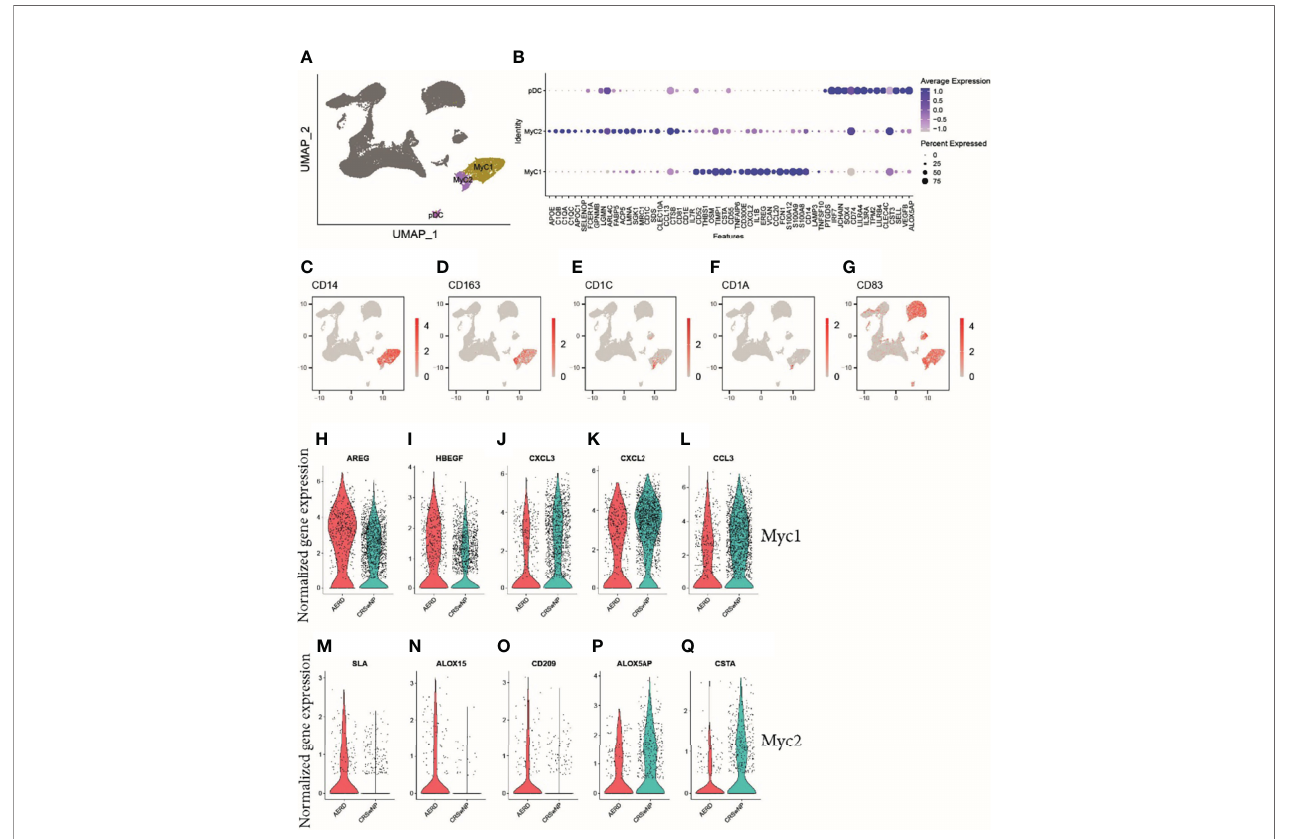
FIGURE 5 | Gene expression of myeloid cells and plasmacytoid dendritic cells in patients with AERD or CRSwNP. (A) Color-coded UMAP plot of scRNA-seq MyC and pDC subclusters. (B) Dot plots showing selected marker genes within MyC1, MyC2, and pDC displaying z-score of average expression (blue color intensity) and frequency of gene expression (circle size). (C – G) Feature plots identifying combined natural log-transformed normalized expression. Red color displays intensity levels of natural log-transformed gene expression. (H – Q) Violin plots showing natural log-transformed normalized gene expression for selected DEG in AERD (red) versus CRSwNP (blue) patients in (H – L) MyC1 and (M – Q) MyC2. AERD, aspirin-exacerbated respiratory disease; CRSwNP, chronic rhinosinusitis with nasal polyps; DEG, differentially expressed genes; MyC, myeloid cell; pDC, plasmacytoid dendritic cell; UMAP, Uniform Manifold Approximation and